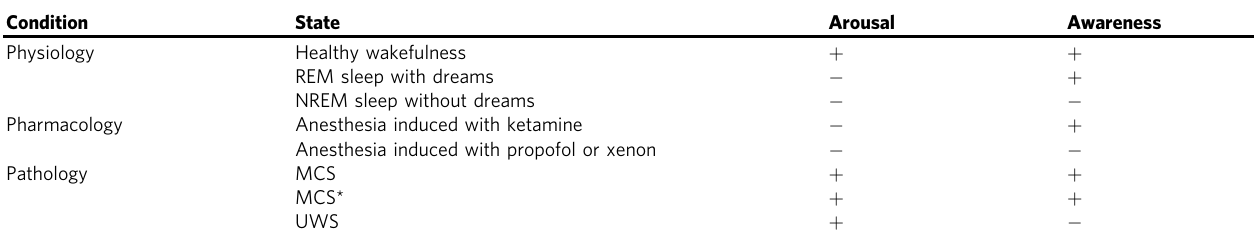
Table 1 Schematic representation of different states of consciousness according to low or high arousal and awareness: the plus sign indicates high arousal or awareness, whereas the minus sign indicates low arousal or awareness.